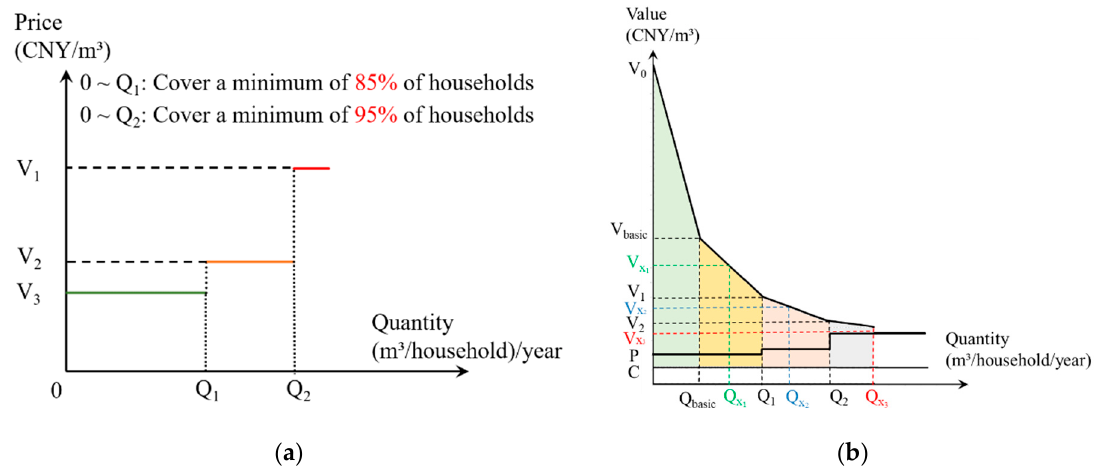
Figure 5. ( a ) Block water pricing policy; ( b ) General structure of the n-part demand function. P i is the water price of i th block; Q i is the water volume of i th block; C is the cost of water; V i is willingness to pay corresponding to the water volume Q i ; Q basic is the volume of basic requirements; Qx i is the allocated water.